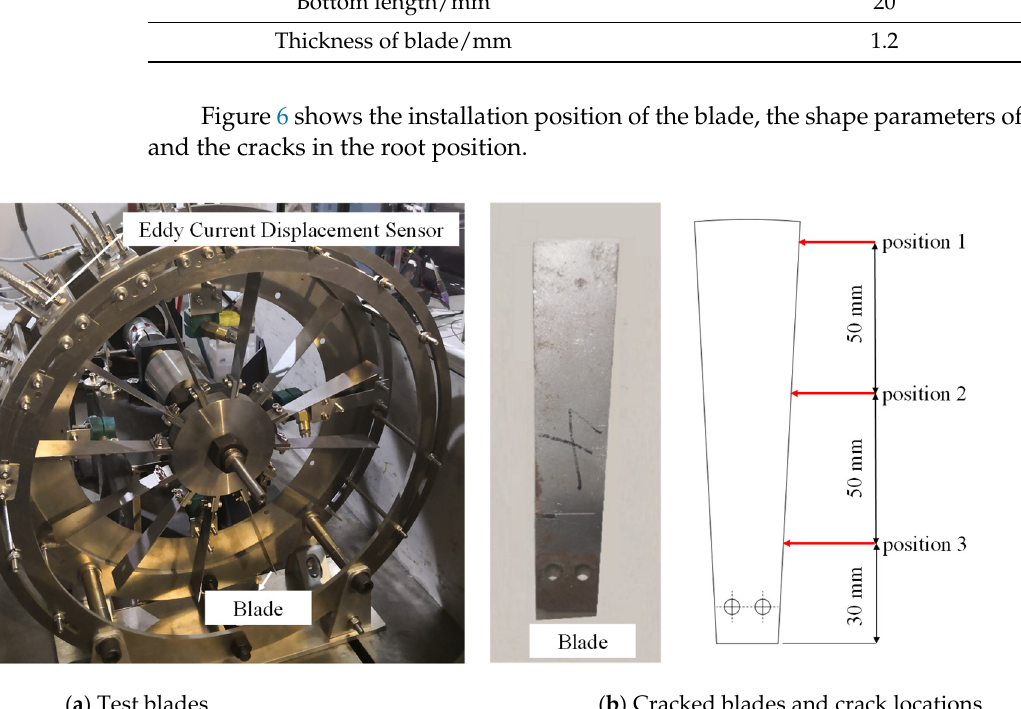
Figure 6. Test blades and crack